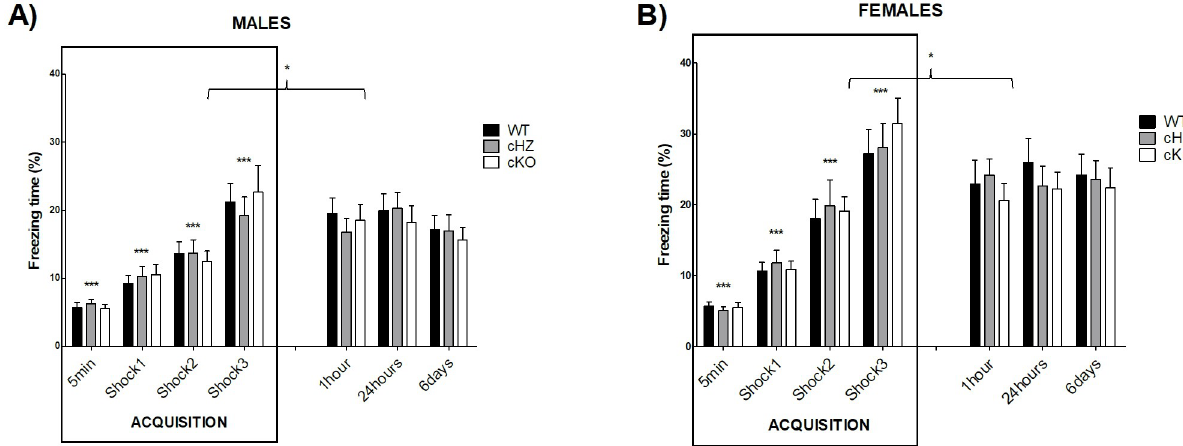
Fig 4. Contextual fear conditioning memory: CFC. The bar plots represent the percentage of freezing (Mean and SEM) during each trial, for the groups WT ( Grik4 Cre+/+ , SV2A lox/lox ), cHZ ( Grik4 Cre+/- , SV2A lox/+ ), and cKO ( Grik4 Cre+/- , SV2A lox/lox ). Males (n = 22) are presented in subfigure A , whereas females (n = 23) are shown in subfigure B . Statistically significant differences were found between sex, with p < .001. ( ��� ) indicates that each marginal mean (given by the main effect of the factor shock), is significantly different from the rest, being the last one (shock 3) the largest, as yielded by Bonferroni tests taken at p < .001. ( � ) indicates that the marginal mean corresponding to the shock 3 is significantly different from the marginal means corresponding to the CFC evaluation, as yielded by Bonferroni tests taken at p < .05.